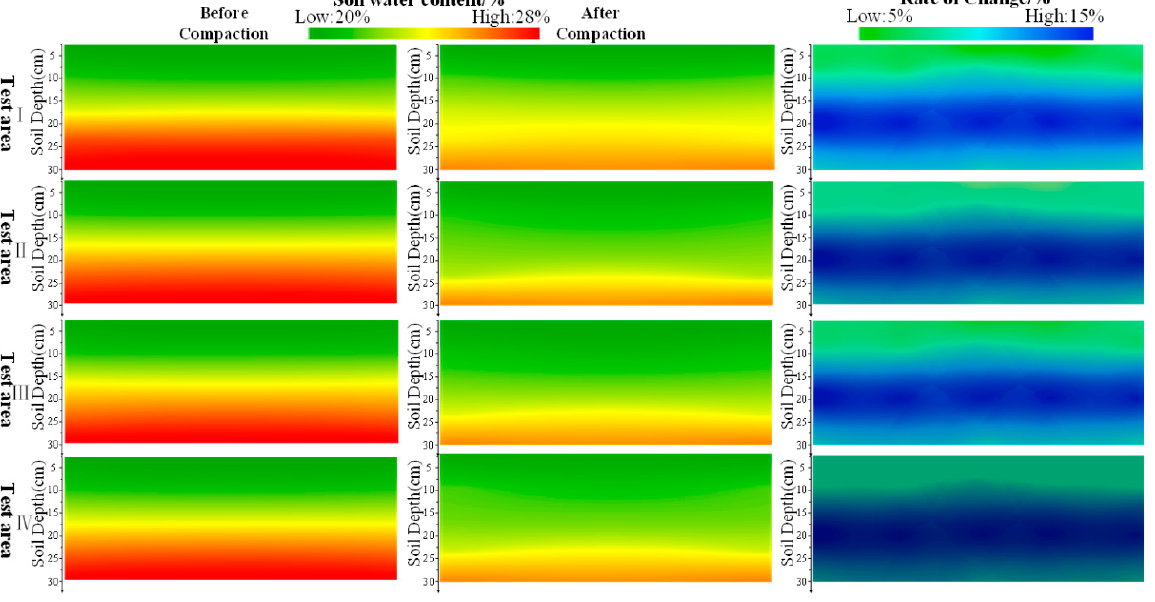
Figure 6. Longitudinal profile clouds of soil moisture content before and after compaction in each test area.